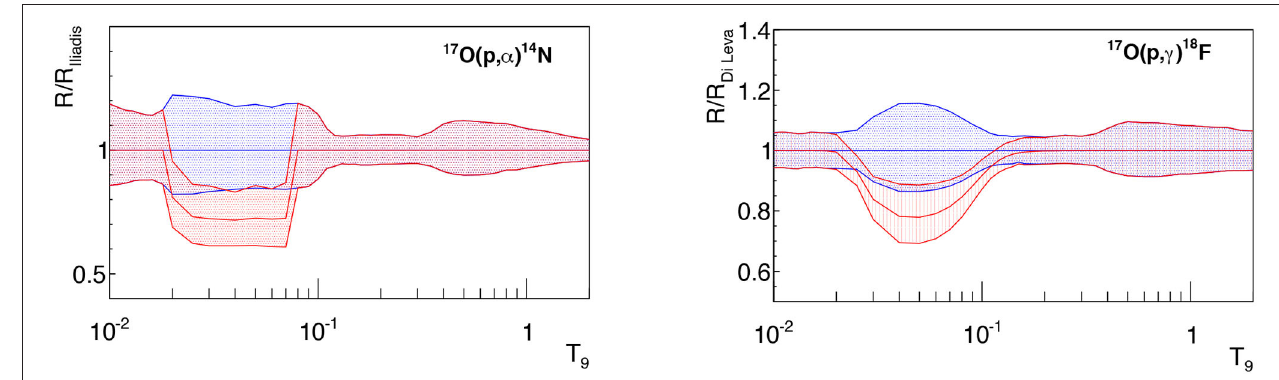
FIGURE 5 | (Left) Comparison of the THM reaction rate of the 17 O(p, α ) 14 N reaction with the direct one (Iliadis et al., 2010). See text for more details. (Right) Comparison of the THM reaction rate of the 17 O(p, γ ) 18 F reaction with the direct one (Di Leva et al., 2014). See text for more